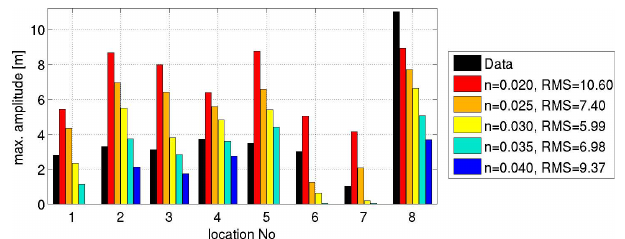
Fig. 10. Flow depth comparison in locations marked in Fig. 9 for different roughness parameters n and the modified source (strike angle 290/320).